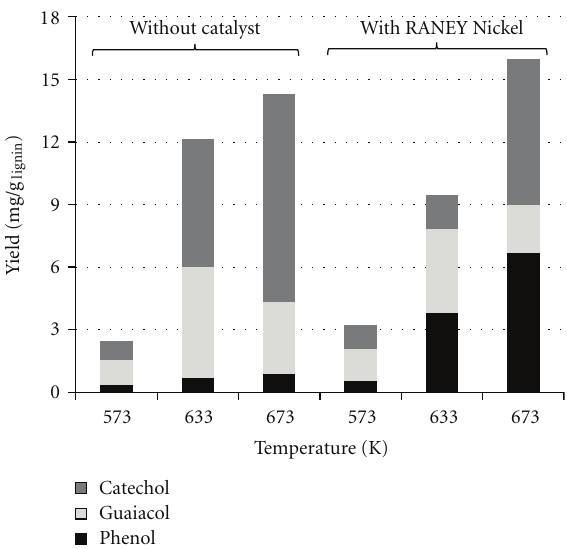
Figure 3: Yield of monoaromatic substances after hydrothermal treatment of lignin with and without catalyst at 30 min reaction